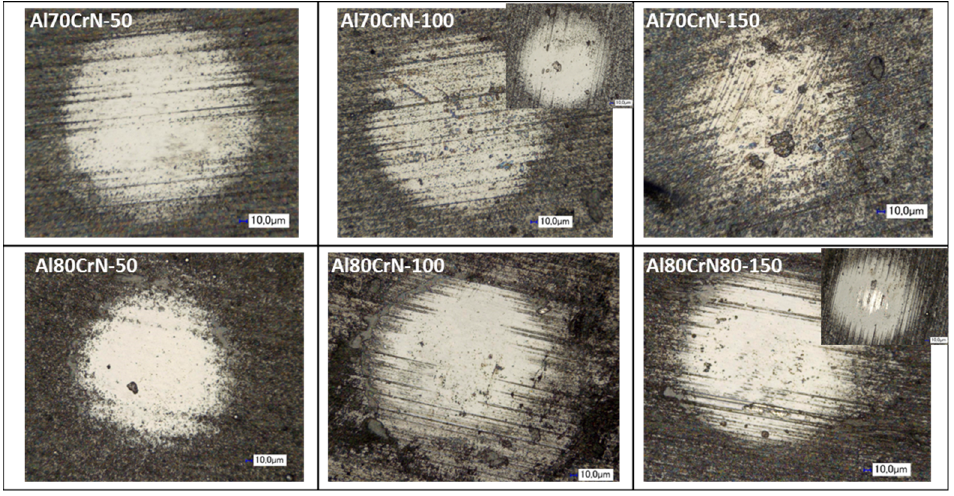
Figure 7. Impact crater images after 10,000 impacts for all variants (insets at Al70CrN–100 and Al80CrN–150 show wear mark after 20,000 impacts).